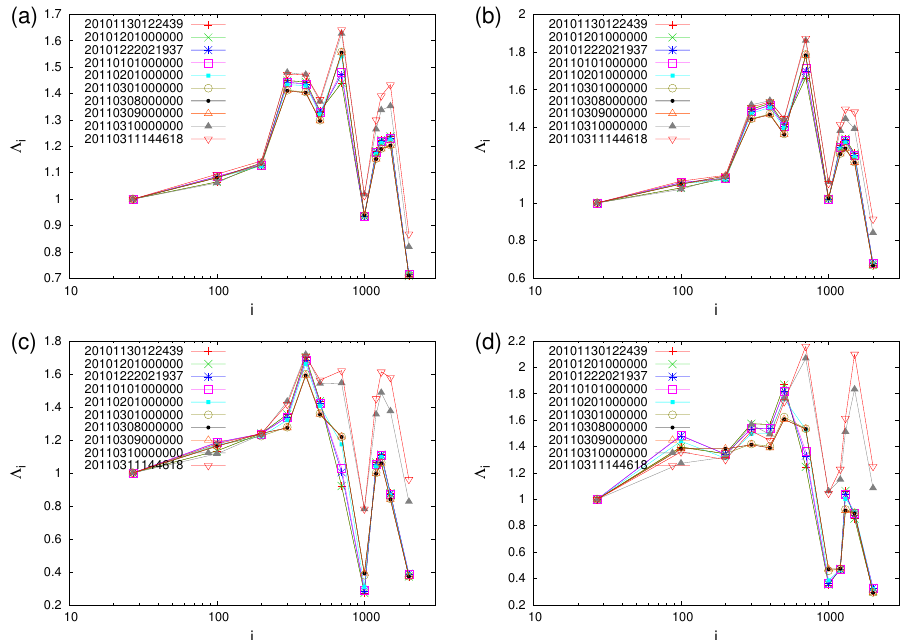
Figure 26. Plot of the Λ i values calculated for all M JMA ≥ 3.5 EQs in the candidate epicentral region depicted in Figure 7 versus the scale i (number of events) by starting the calculation almost 5 years ( a ), 3 years ( b ), 2 years ( c ), and around 14 months ( d ) before the M 9 Tohoku EQ. For each scale, the Λ i values are depicted at the following dates: 30 November 2010 (just before the M 7.1 EQ on this date, pluses in red), 1 December 2010 (crosses in green), 22 December 2010 (just before the M 7.8 EQ that occurred on this date, asterisks in blue), 1 January 2011 (open squares in magenta), 1 February 2011 (solid circles in cyan), 1 March 2011 (open circles in olive green), 8 March 2011 (solid circles in black), 9 March 2011 (open triangles in orange), 10 March 2011 (gray filled triangles) and 11 March (almost 10 min before the M 9 Tohoku EQ occurrence, inverted red triangles). Taken from Ref.